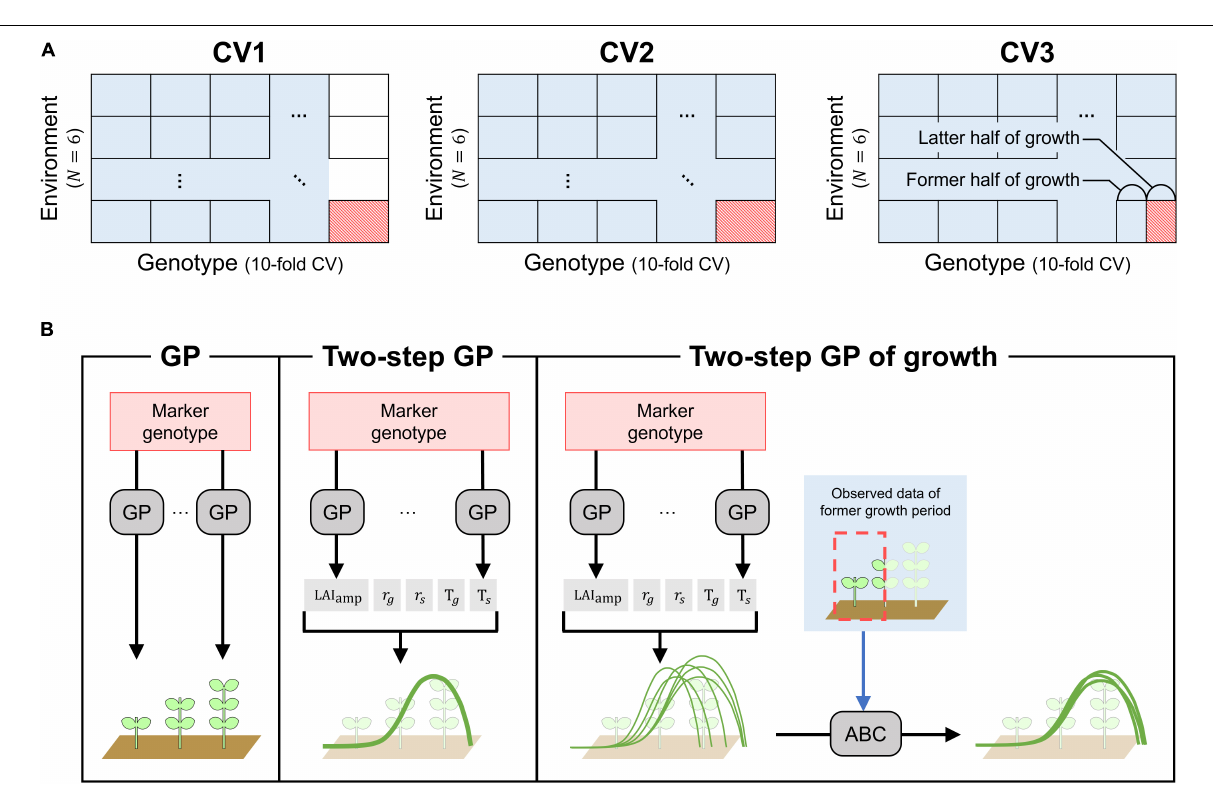
FIGURE 3 | Cross-validation schemes and prediction models. (A) Cross-validation schemes (CV1, CV2, and CV3). Training and test data in cross-validation are expressed as blue and red cells, respectively. (B) Structures of prediction models (GP, TGP, and TGPG). Structures of the other prediction models with multivariate GP (MGP, TMGP, TMGPG) can be understood by replacing GPs in the figure to